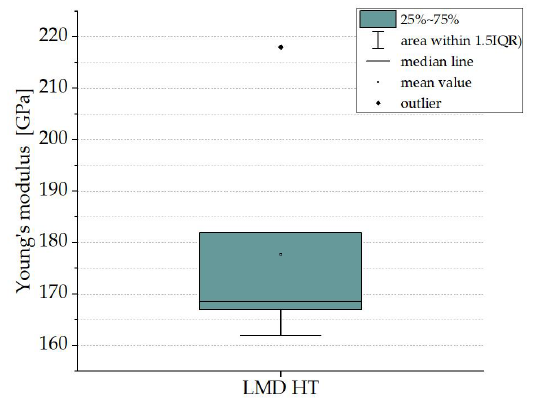
Figure 13. Box plot of Young’s modulus data for heat-treated LMD samples.